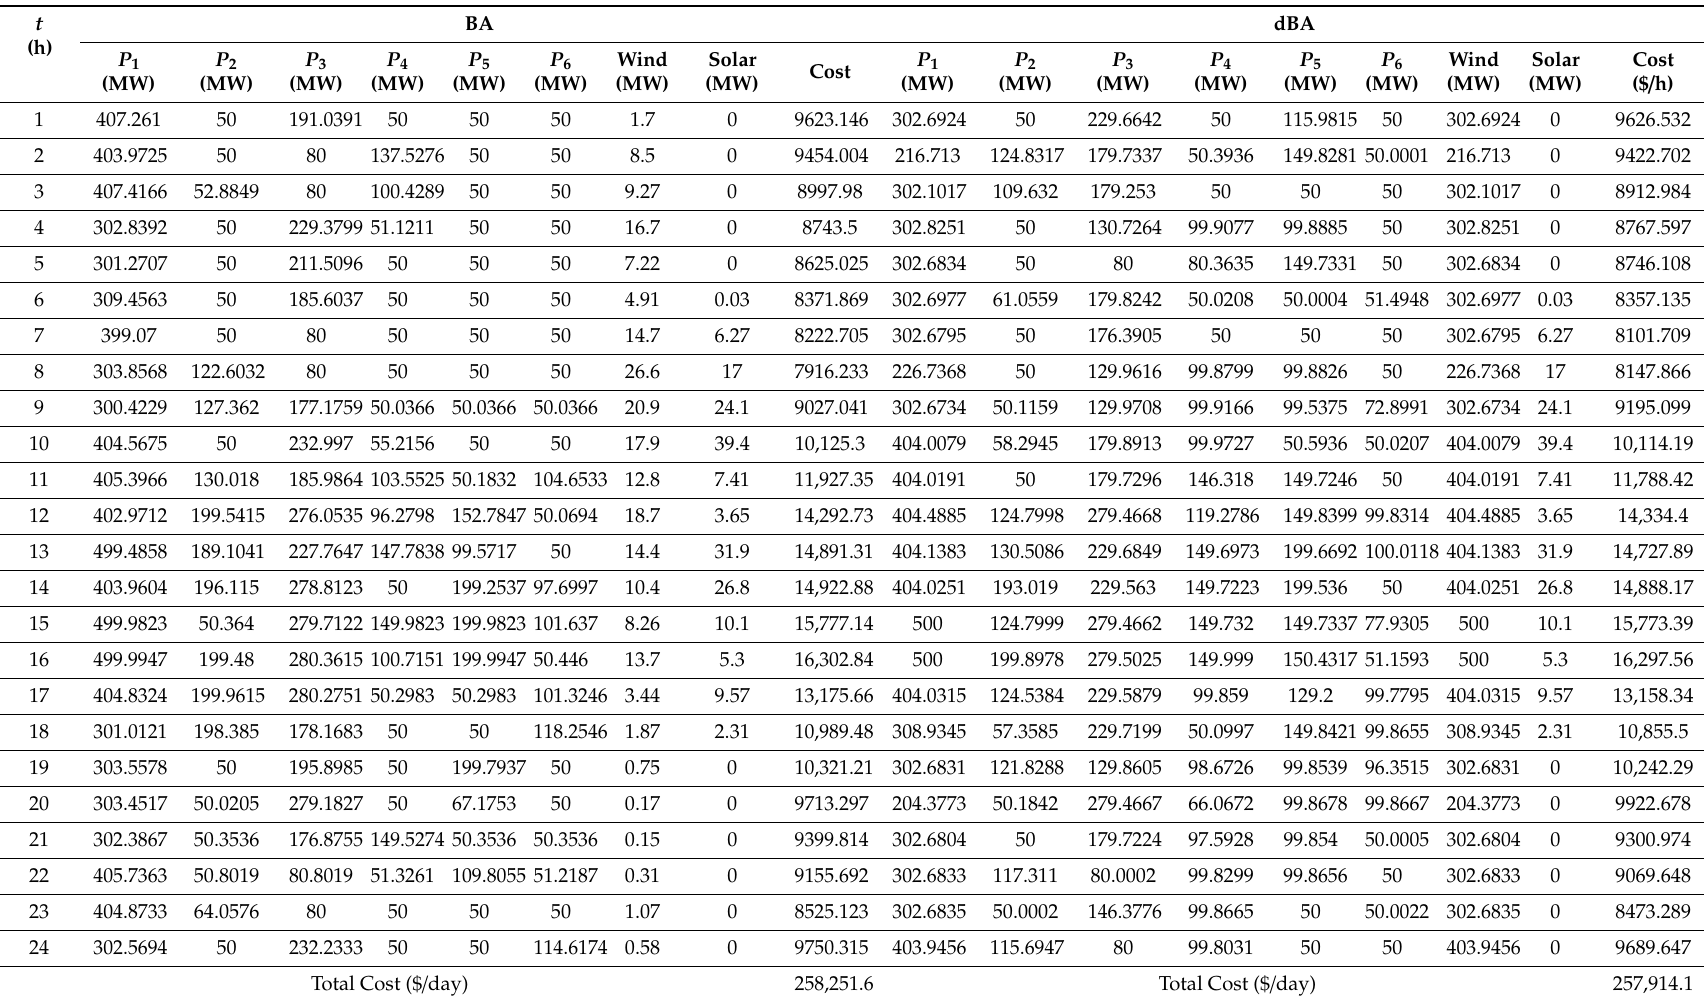
Table 18. The BA and dBA on a six-thermal unit system with renewables (wind and